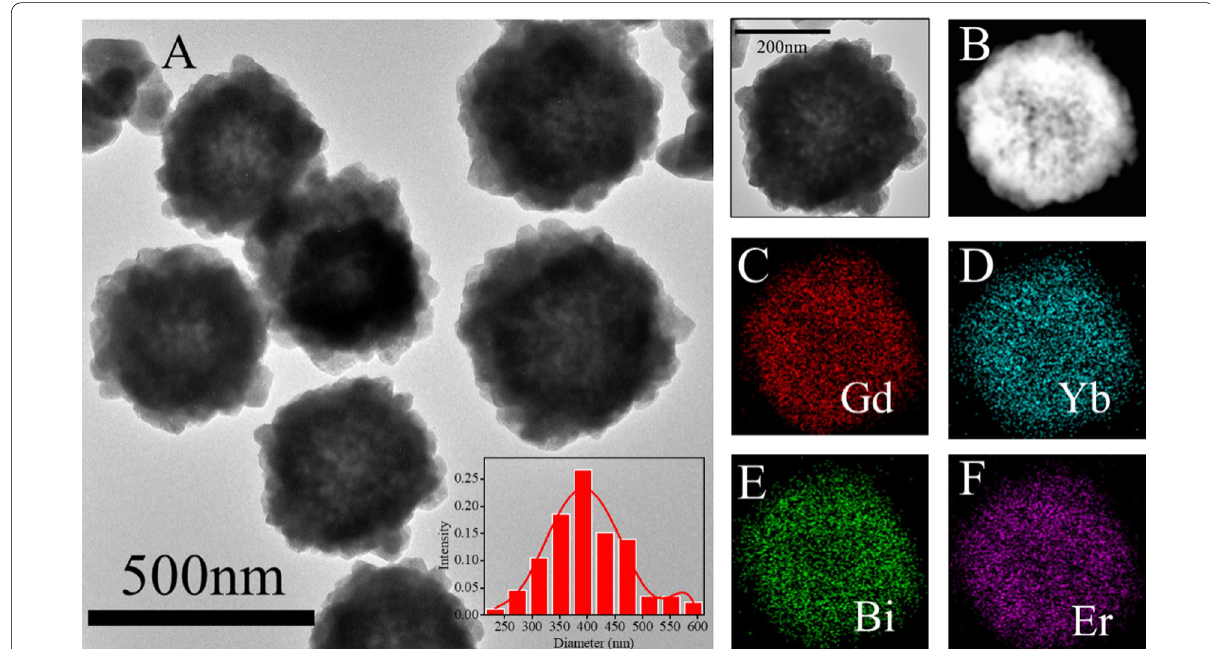
Fig. 1 Morphology and particle size of the BiF 3: Ln@PVP NPs. A TEM images of the BiF 3: Ln@PVP NPs and its particle size distributions (bottom right). B – F Dark-field TEM of image of BiF 3: Ln@PVP NPs and corresponding TEM elemental maps of Gd, Yb, Bi and